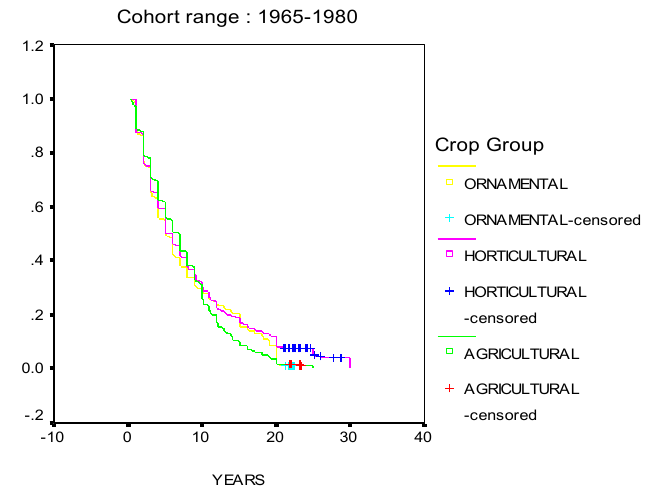
Figure 3. Kaplan-Meier Product Limit Estimates of Survival Function of PVP Certificates of Different Crop Groups by Time